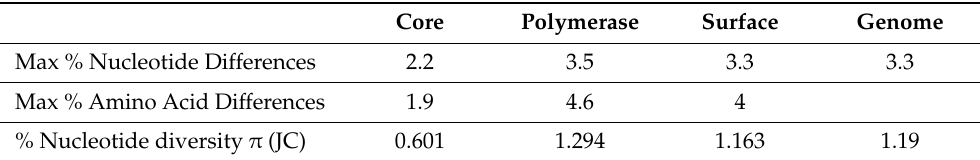
Table 1. Nucleotide diversity calculated by percent differences in pairwise